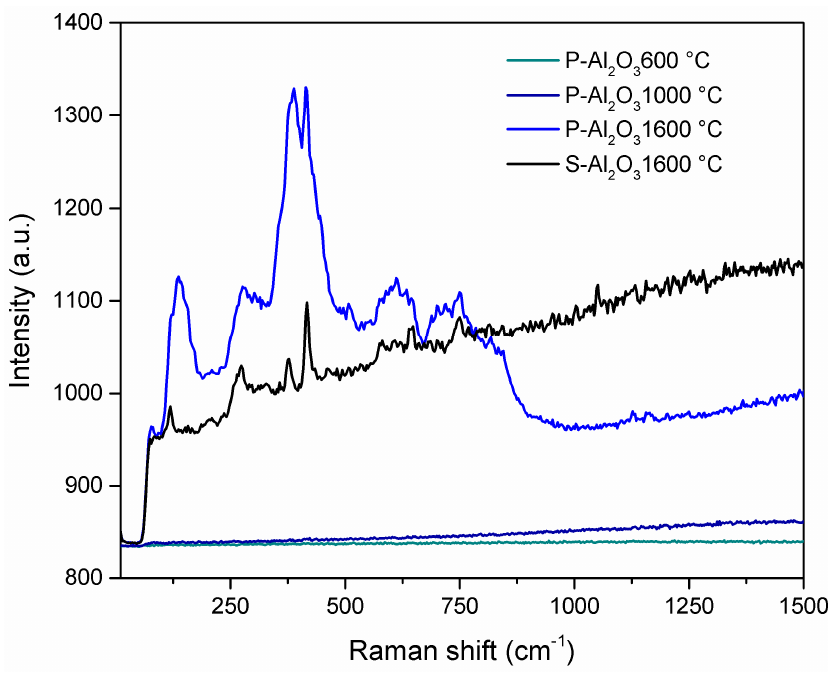
Figure 3. Raman spectra of the alumina powders and sphere treated at different temperatures.